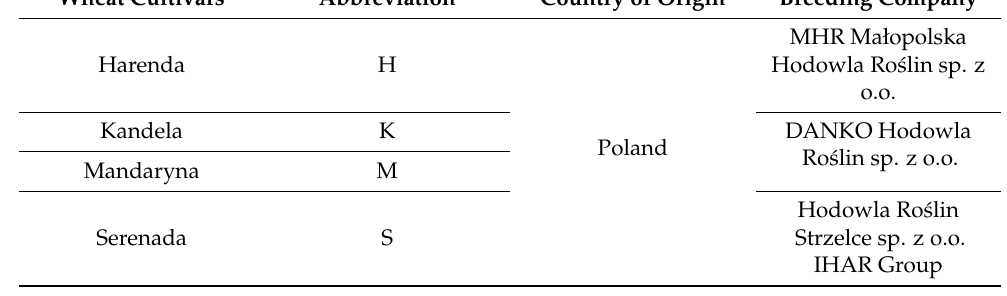
Table 3. List of wheat cultivars tested.